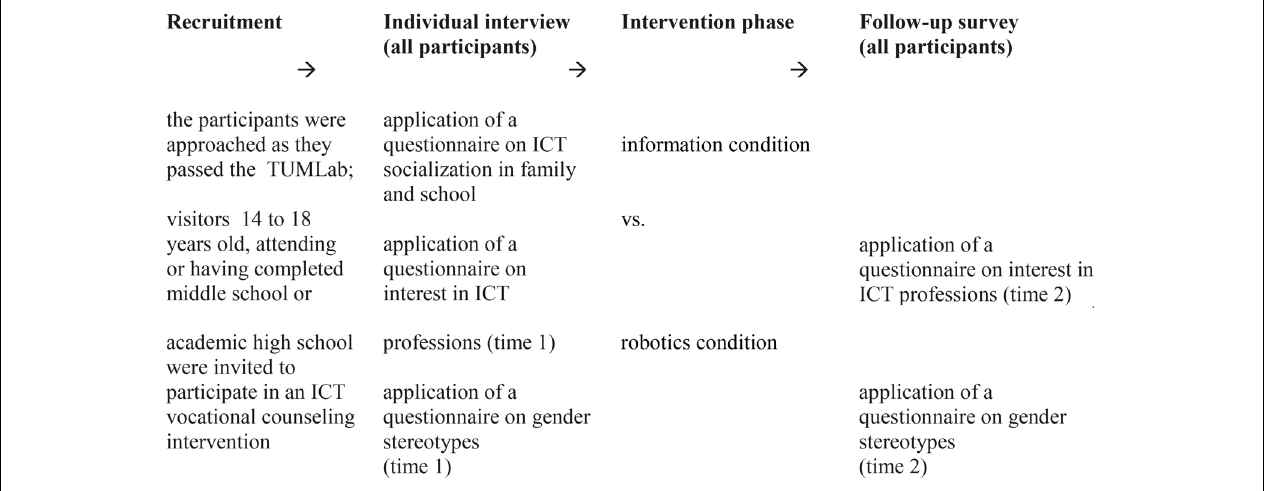
FIGURE 1 | Temporal sequence of the